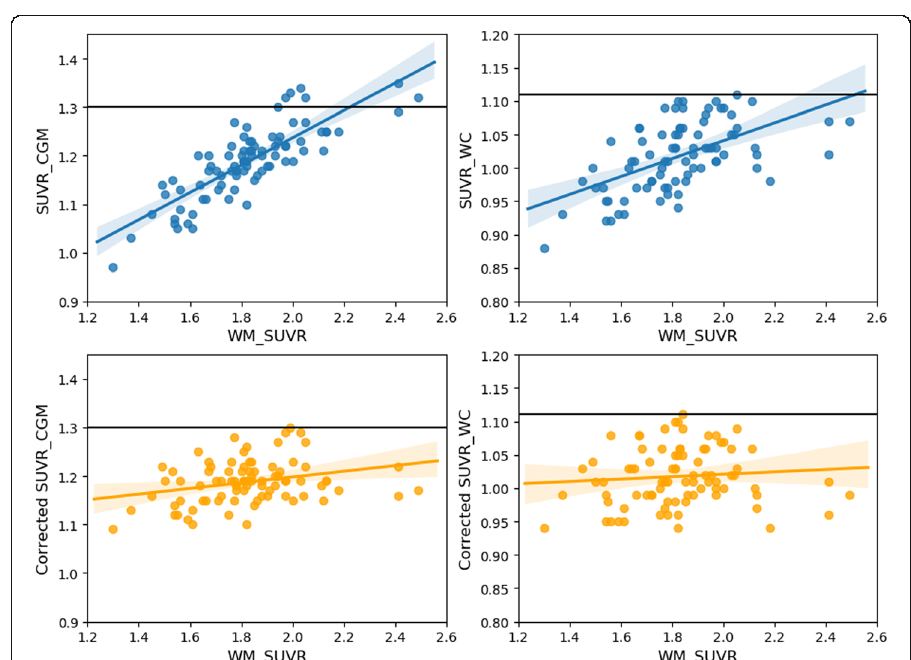
Fig. 7 ADNI data corrected applying the linear relation obtained from Monte Carlo simulation. Blue points represent uncorrected data, while orange points represent corrected data. Values are represented for SUVR CGM (left) and SUVR WC (right). Threshold values of SUVR CGM = 1.30 and SUVR WC = 1.11 are plotted for representation purposes